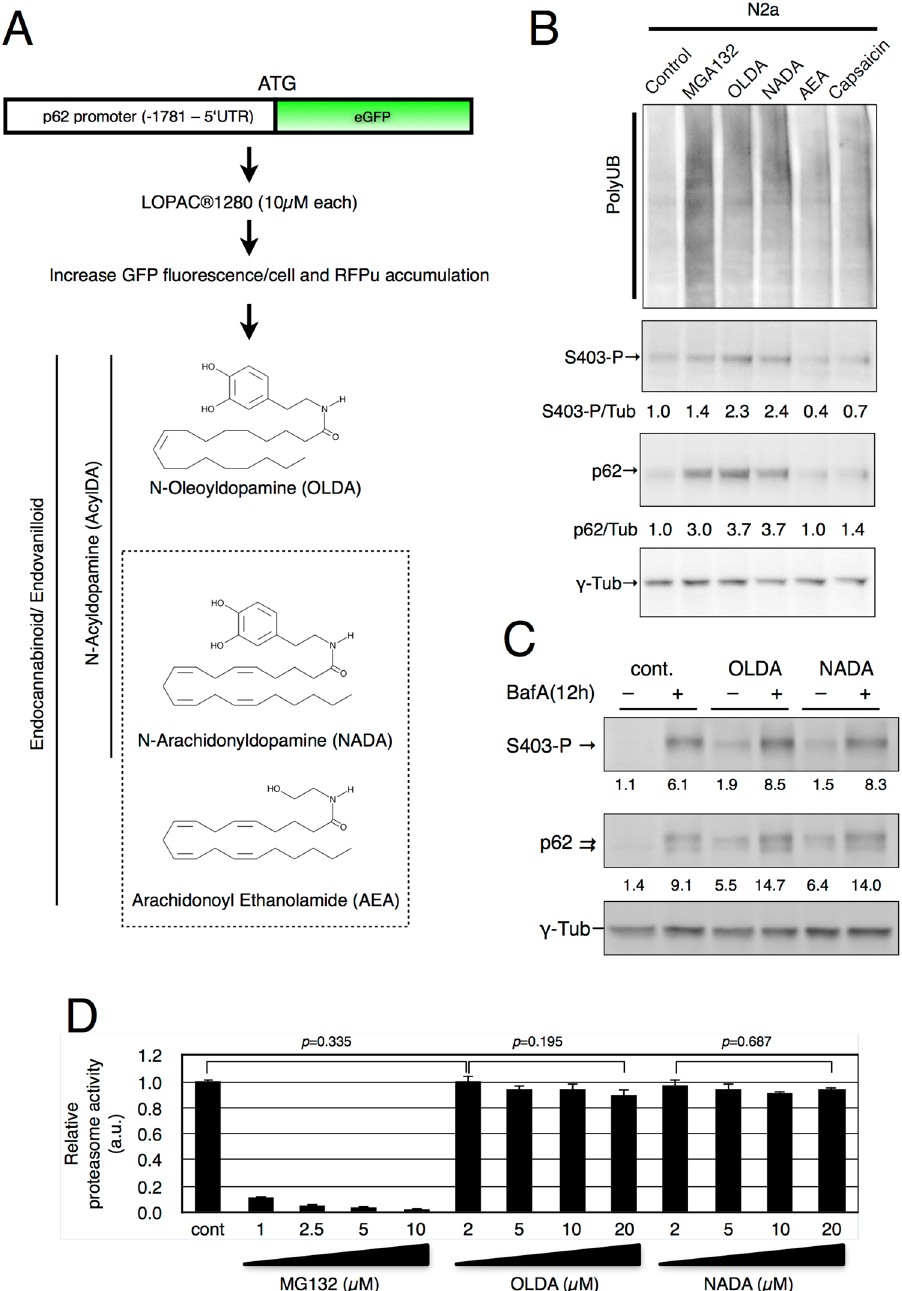
Figure 1. Drag screening for p62 promoter activation compounds. ( A ) A scheme of p62 promoter ( − 1781 to 5 ′ untranslated region of p62 exon 1)-driven EGFP gene (p62PR-EGFP) and drug screening using LOPAC1280 ® library. The compounds that induced GFP expression and RFPu accumulation were selected and the chemical structures of OLDA, NADA, and AEA are shown ( B ). Normal N2a cells were treated with 5 µ M OLDA, 5 µ M NADA, 10 µ M AEA, 50 µ M capsaicin, or 1 µ M MG132 for 12 h as indicated ( C ). N2a cells were treated with